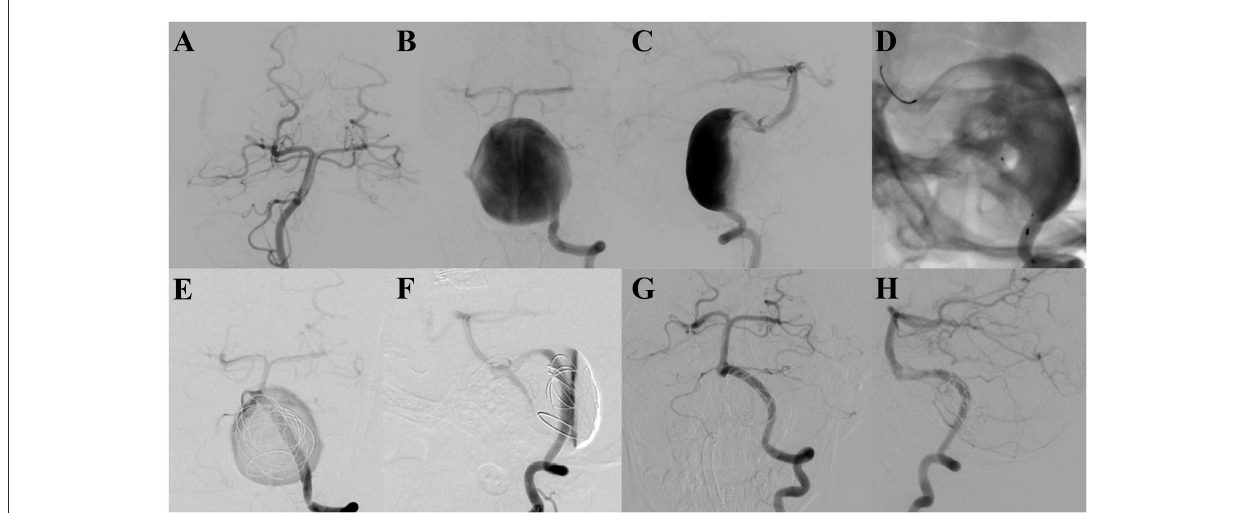
FIGURE1 (A–C) Pre-operative digital subtraction angiography indicates a giant dissecting aneurysm located at the end of the left vertebral artery. (D) Three overlapping and successfully implanted pipeline embolization devices are shown. (E, F) Digital subtraction angiography analysis, showing the retention of contrast media in the aneurysm after the treatment. (G, H) Follow-up digital subtraction angiography, revealing the aneurysm to be completely occluded 9 months after the procedure.